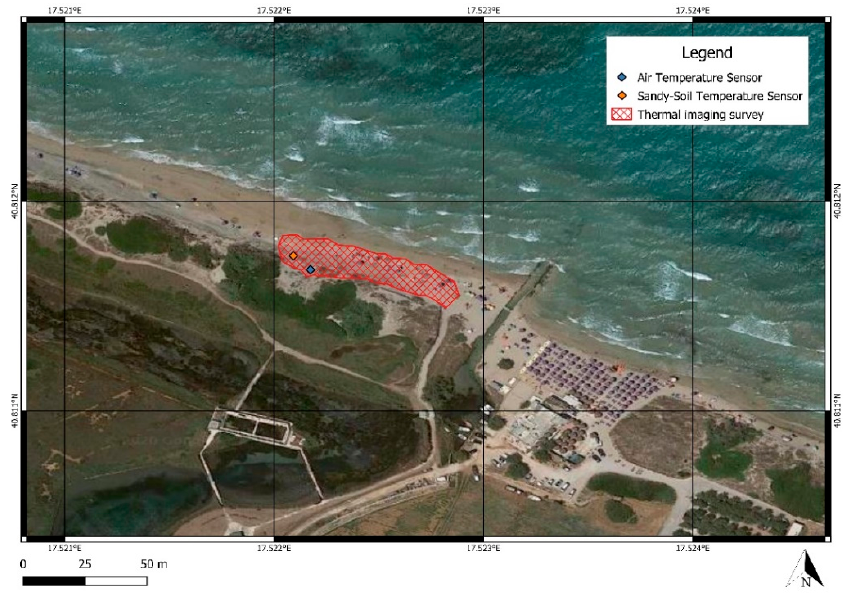
Figure 3. Sensor localization; and IR thermography survey area.